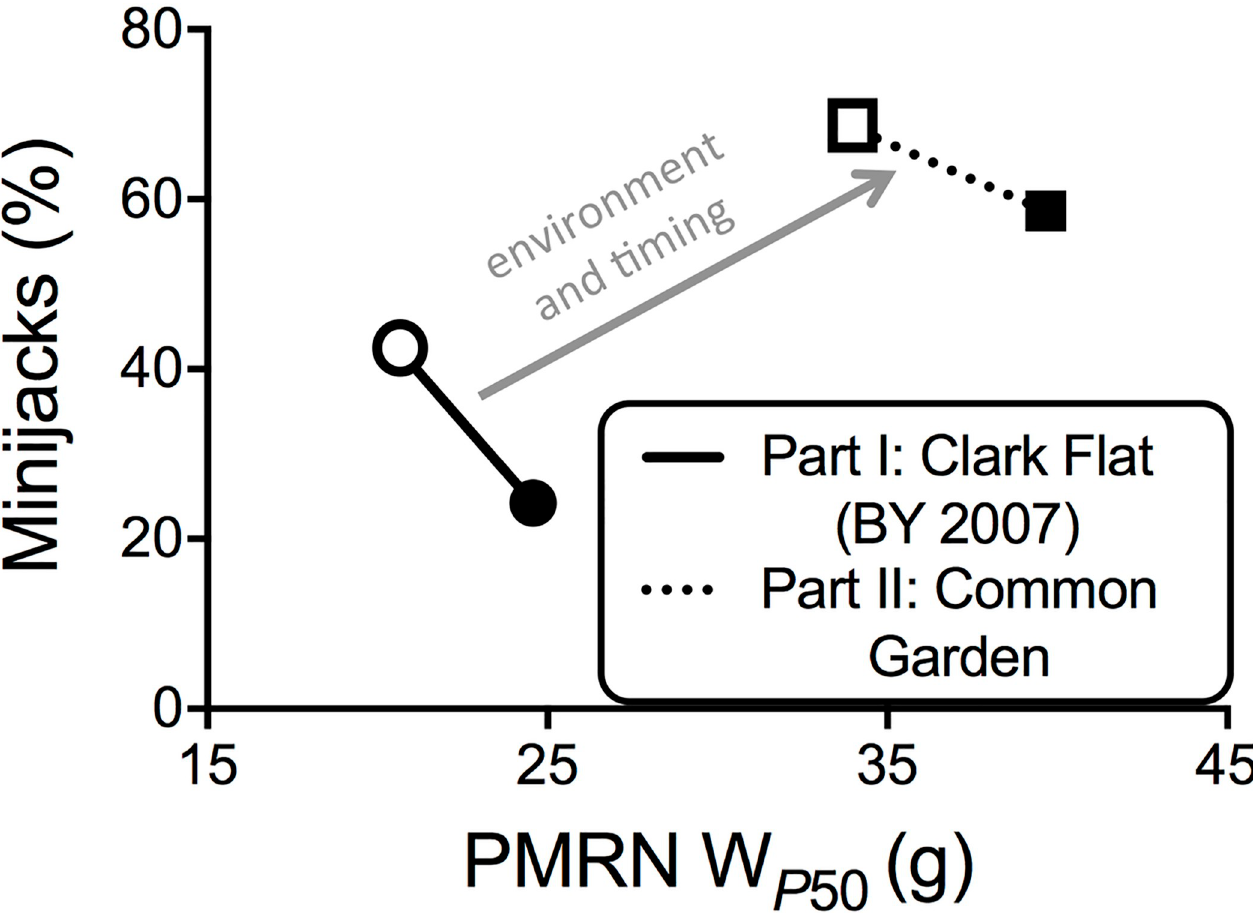
Fig 11. Comparison of age-2 minijack rate and PMRN W P50 estimates from Part I and Part II. Relative difference in the relationship between the mean age- 2 minijack rate and mean PMRN W P 50 of the integrated/founder (INT/FNDR) and segregated (SEG) broodline from Part I and Part II of this investigation; both groups presented were progeny of BY 2007 broodstock. Open symbols = INT; closed symbols = SEG.